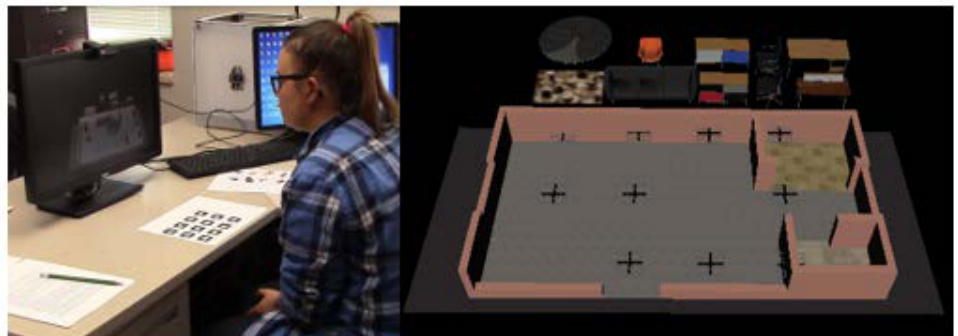
Figure 6. The virtual reality working